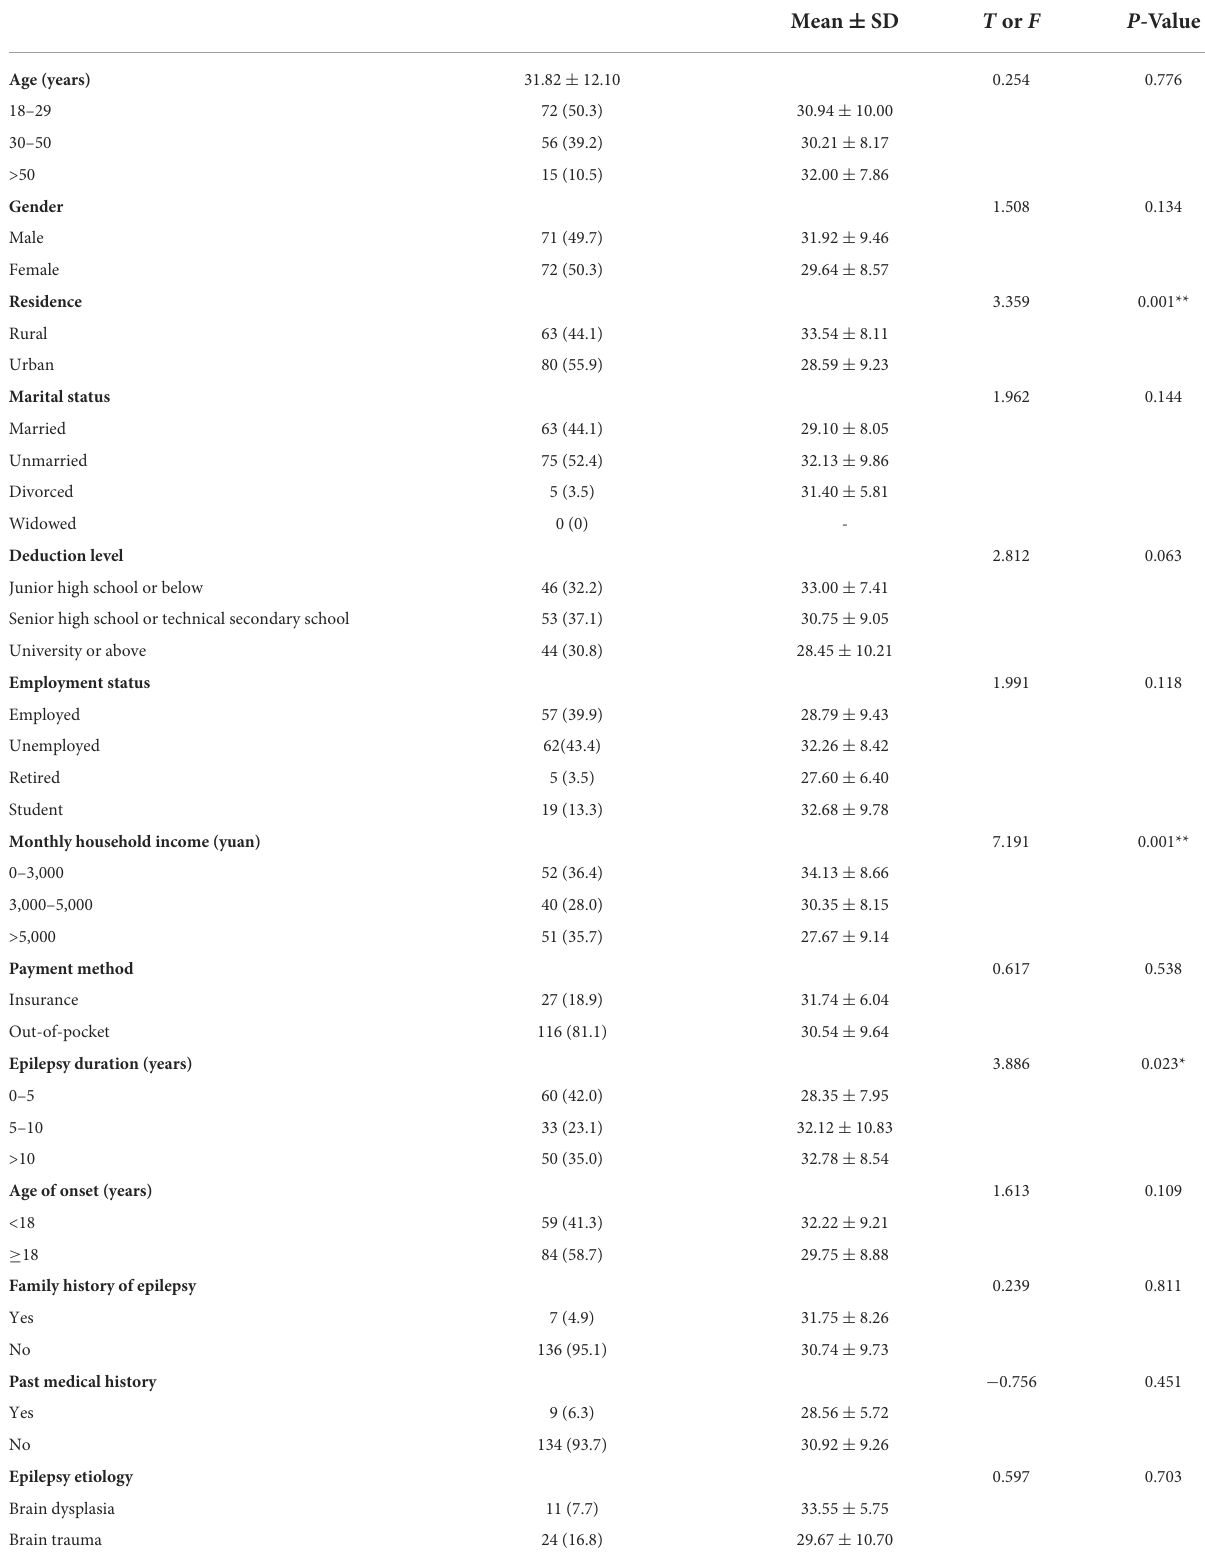
TABLE 1 Sociodemographics data, clinical characteristics, and SPBS score of adult epilepsy patients ( N = 143).